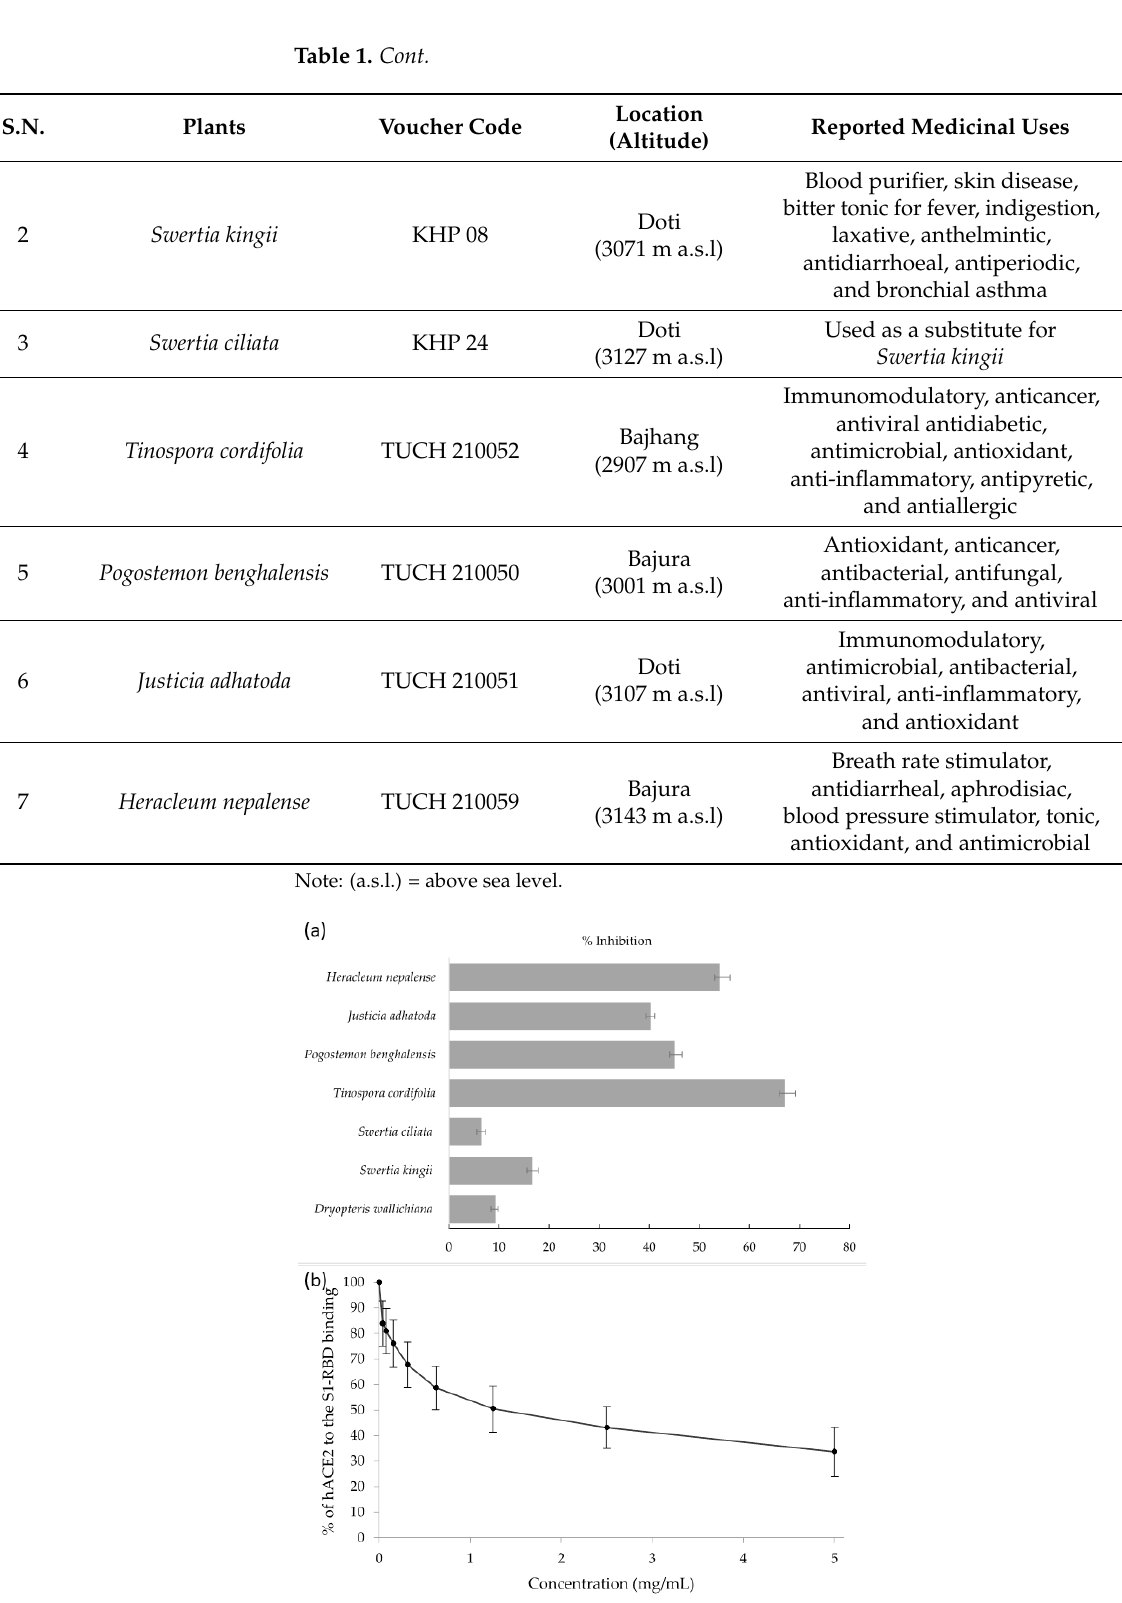
Figure 1. ( a ) Percentage inhibition of hACE2 binding with S1-RBD exhibited by plant extracts (5 mg/mL); ( b ) binding curve of hACE2 receptor to S1-RBD protein of SARS-CoV-2 in the presence of a range of crude extracts from T. cordifolia as determined by ELISA. The data represent mean ± SEM from n = 3 samples. Table 1. Screening of crude extracts (5 mg/mL) of ethnomedicinal plants based on S1-RBD assay with their reported medicinal uses. S.N.